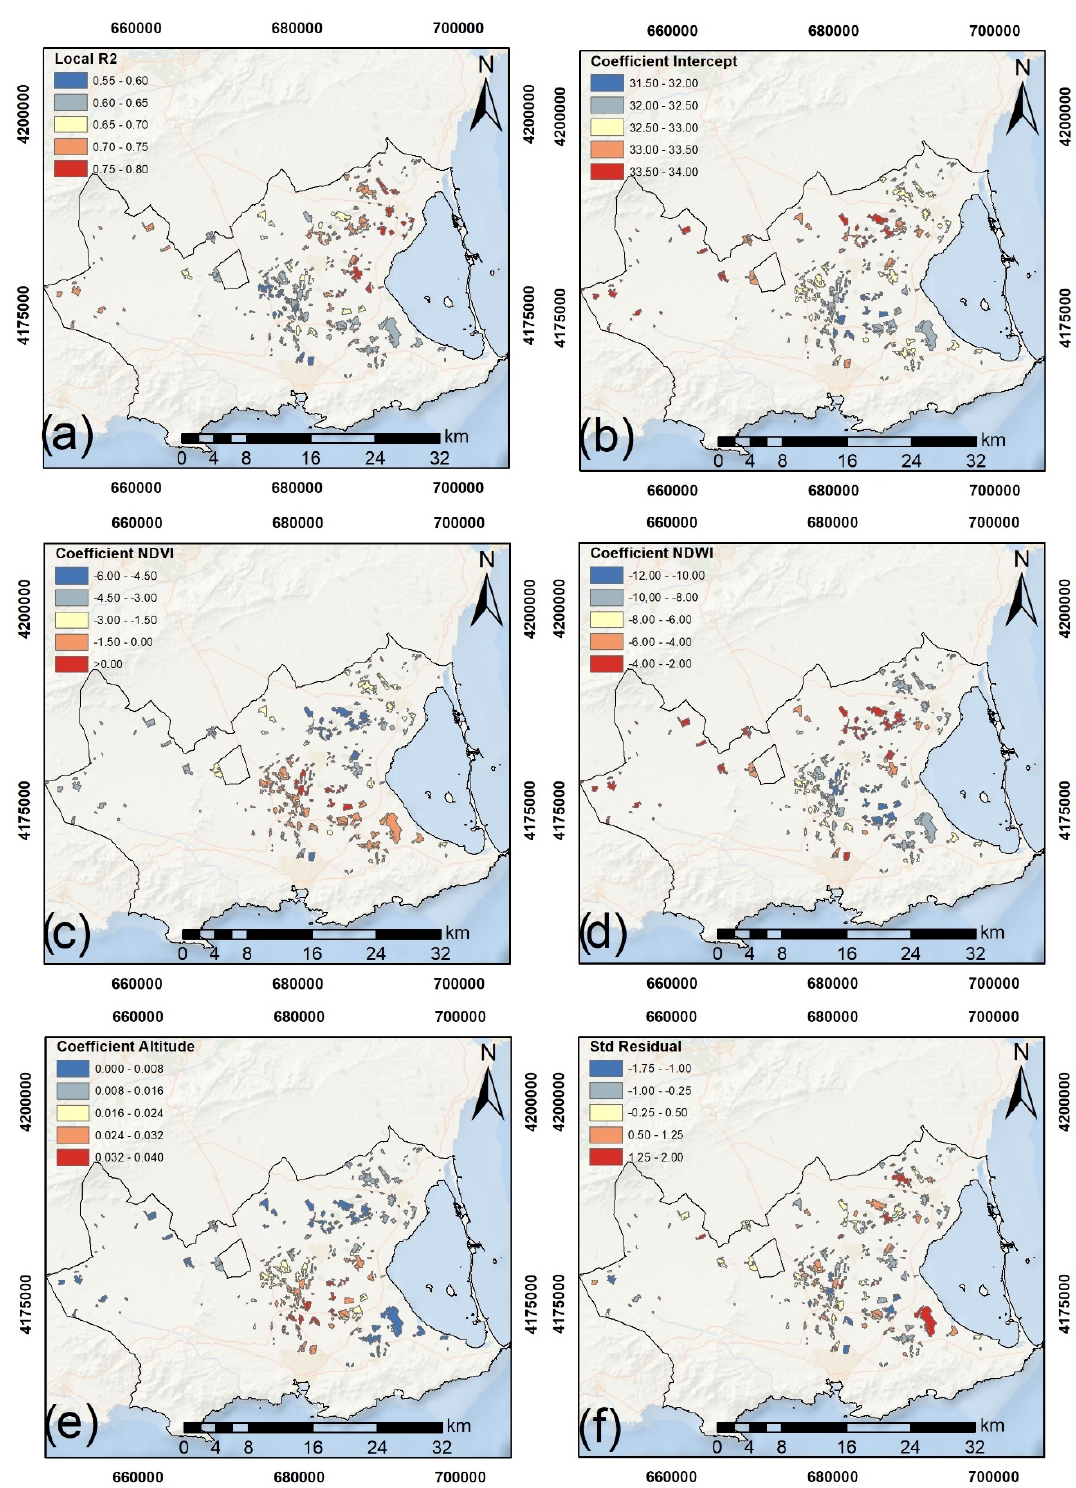
Figure 3. Spatial distribution of Local R 2 ( a ); local coefficients in the GWR model: the intercept ( b ); Normalized Difference Vegetation Index (NDVI) ( c ); Normalized Difference Water Index (NDWI) ( d ); Altitude ( e ); and standard residuals ( f ).